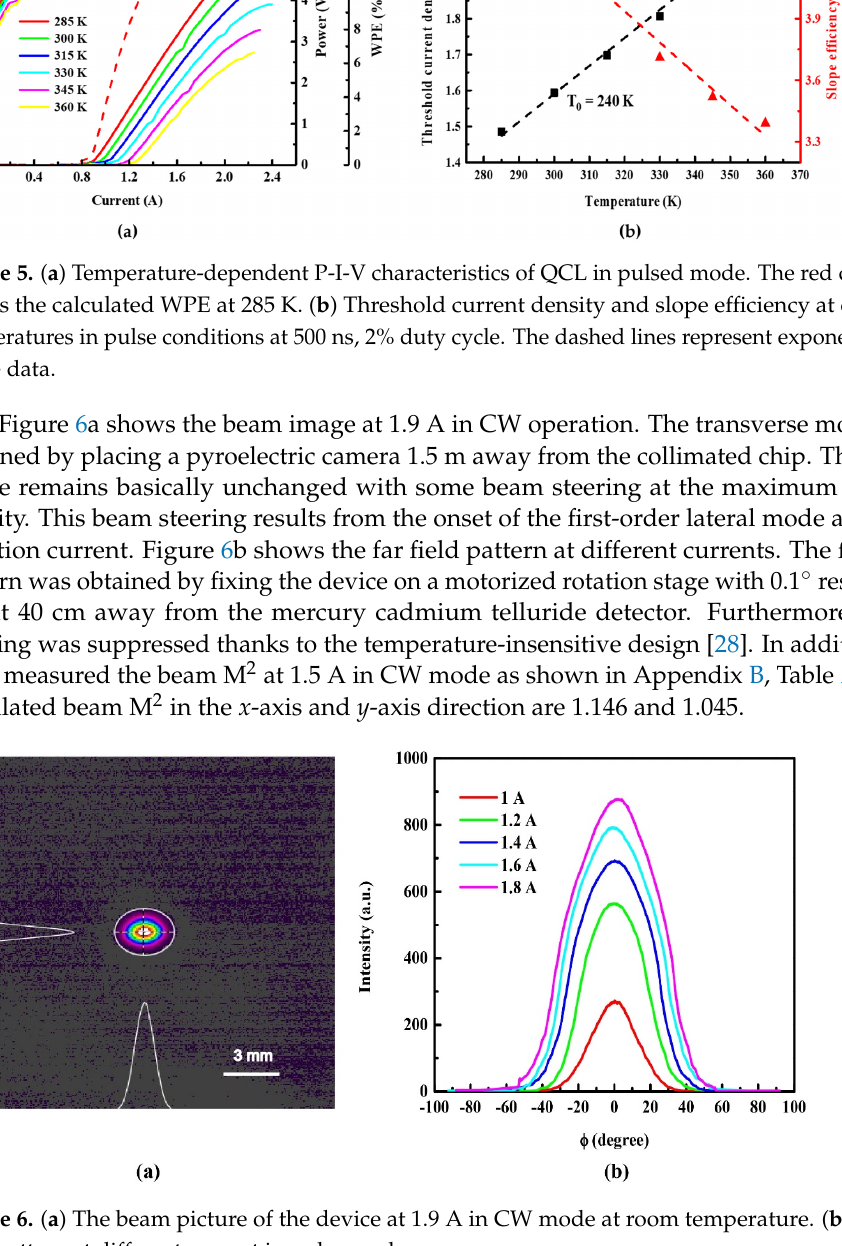
Figure 6. ( a ) The beam picture of the device at 1.9 A in CW mode at room temperature. ( b ) The far field pattern at different current in pulse mode.